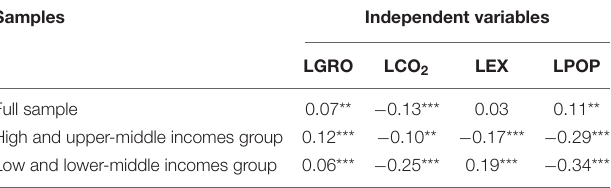
TABLE 10 | Robustness check using